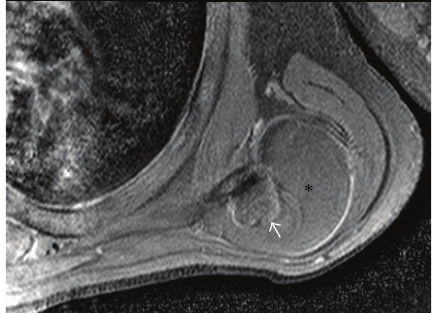
Figure 4: T1 fat saturated precontrast axial image showing sup- pression of the T1 hyperintensity suggesting fat component (black asterisk) with bony excrescence (white